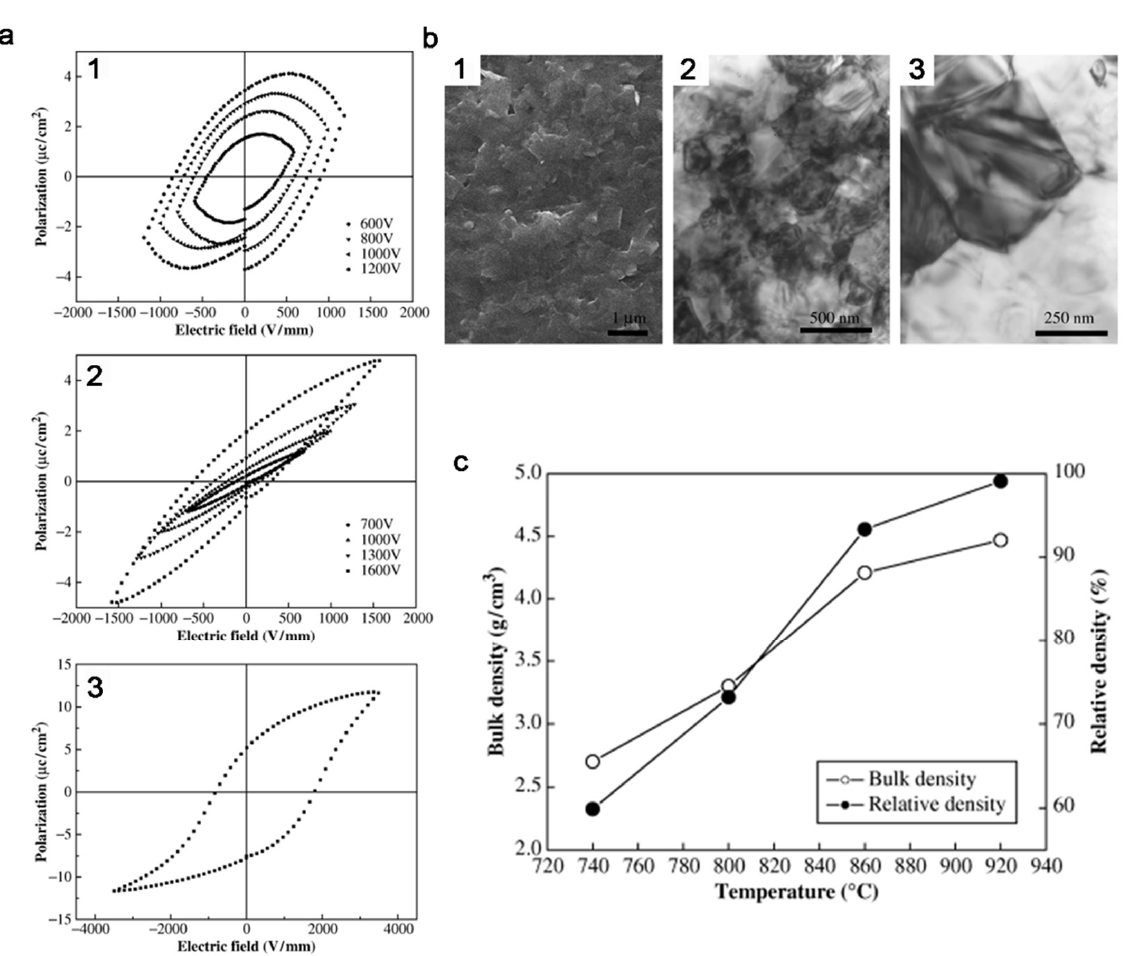
Figure 9. ( a ) Polarization hysteresis curves of the Na 0.5 K 0.5 NbO 3 ceramic spark plasma sintered at 920 °C for 5 min and then annealed at 900 °C for different times in air: (1) 1 h and (2, 3) 4 h. ( b ) Microstructure of the Na 0.5 K 0.5 NbO 3 ceramics: (1) Scanning electron microscopy micrograph and (2, 3) transmission electron microscopy micrographs. ( c ) Density change of the spark plasma sintered sample as a function of spark plasma sintering (SPS) temperature. Reproduced with permission [109]. Copyright 2005, John Wiley and Sons.